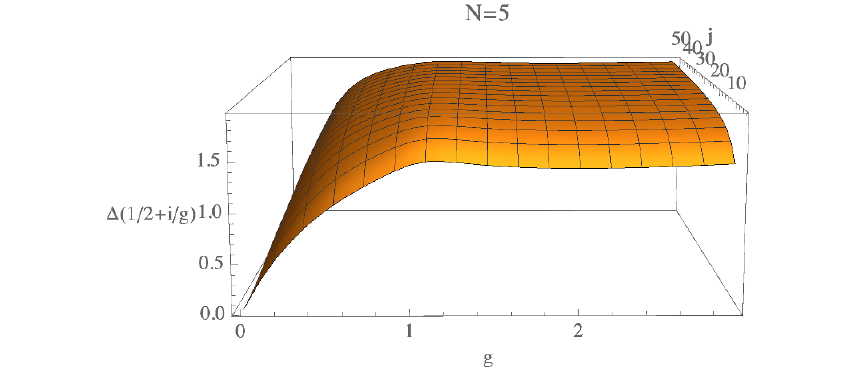
Figure 9. g (cid:0) j plot for the interpolating function (5.9) for N = 5 for (cid:18) = (cid:25) and (cid:28) = 1 = 2+ i=g . The interpolating function has peak value at g = 2 p point (cid:28) = (cid:28) TS